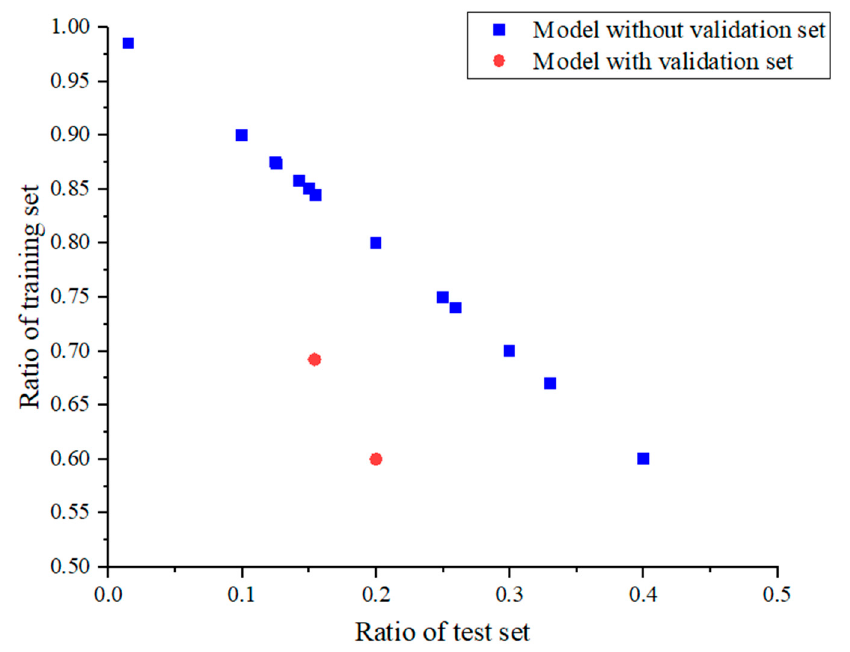
Figure 12. Division proportion of raw data.